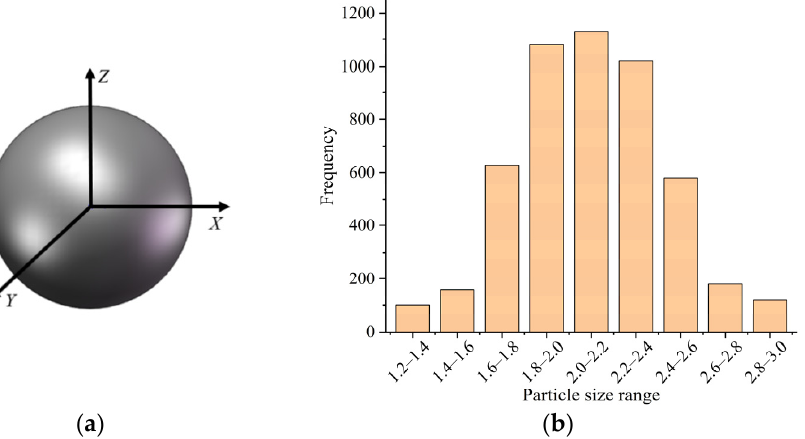
Figure 1. Geometric model and particle size distribution of urea particles: ( a ) Geometric model; ( b ) Particle size distribution.